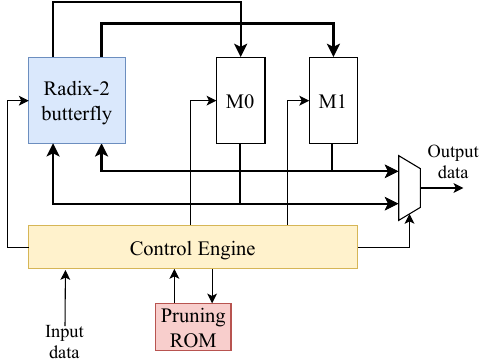
Figure 5. Memory-based architecture for the IFFT modules used in the UFMC